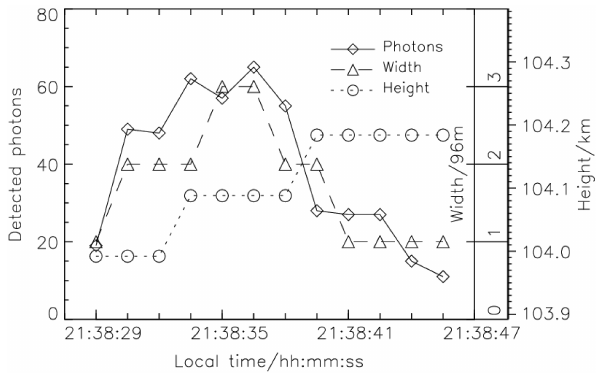
Figure 11. Variations of the trail peak intensity, the width and the peak height, corresponding to Fig. 10.